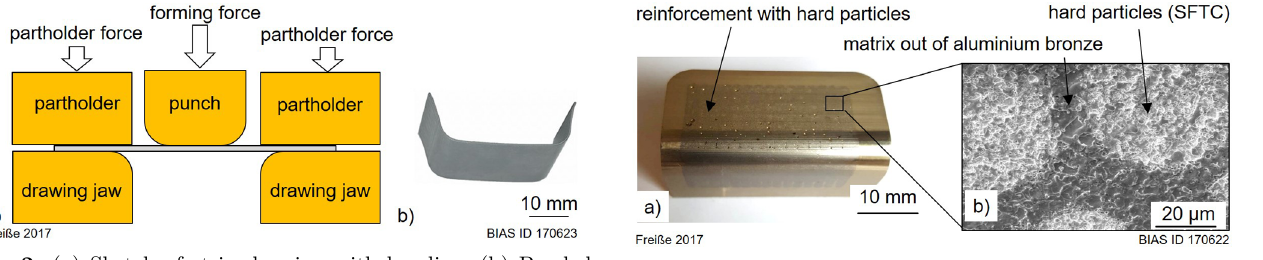
Fig. 3. (a) Drawing die reinforced with hard particles machined by wire EDM. (b) Scanning electron microscope (SEM) image of the surface. Table 2. Material, manufacturing process, and drawing clearance of the drawing